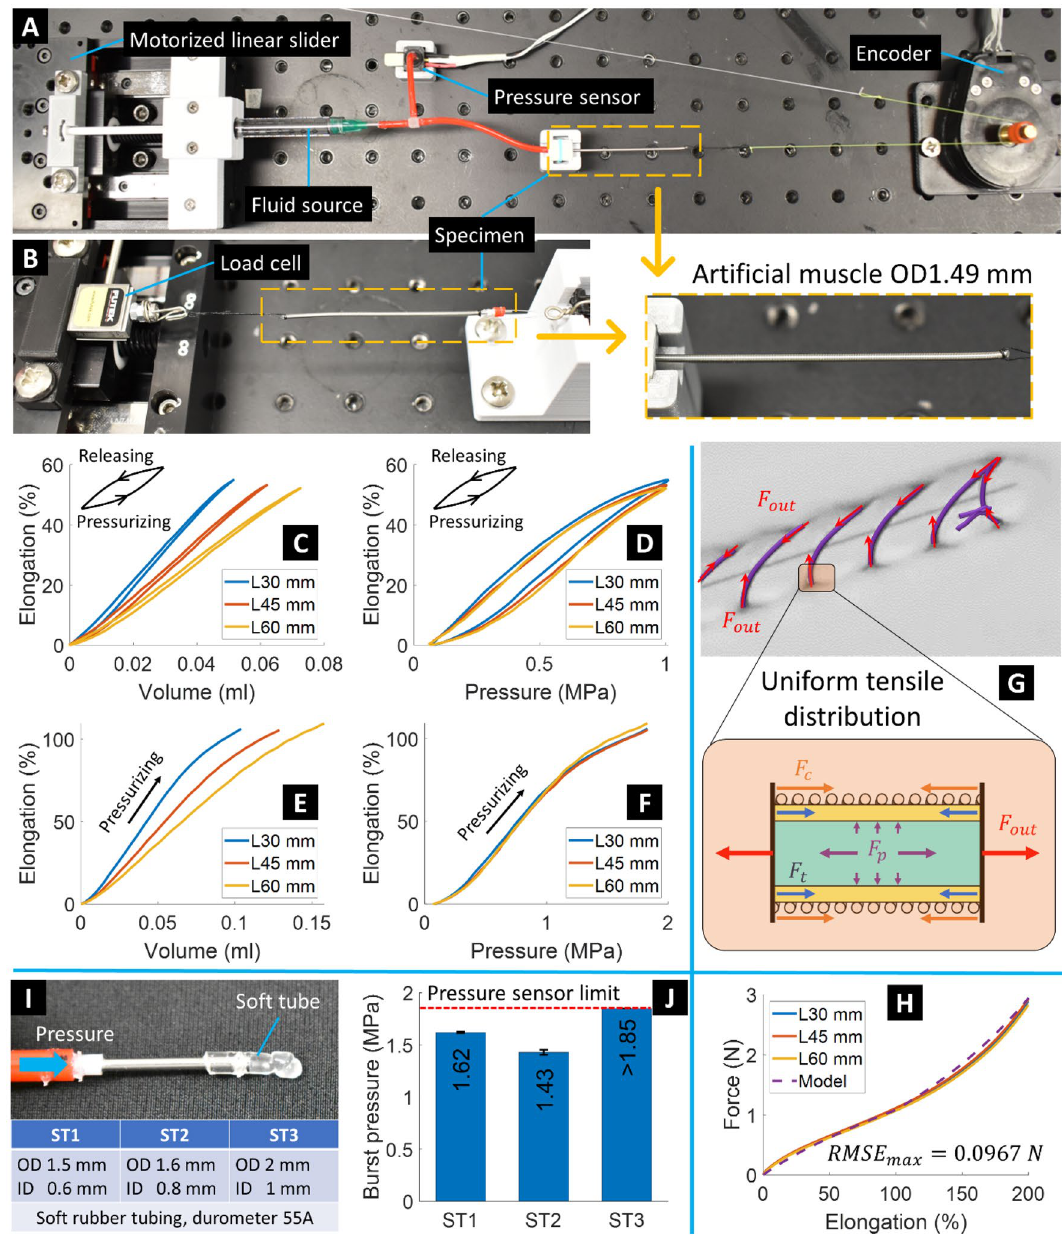
Figure 4. STAM and soft tube characteristics. ( A ) Experimental setup to measure STAM elongation. ( B ) Setup to establish the STAM elongation-force relationship. ( C , D ) Hysteresis profiles of input (volume and pressure) and output elongation of three different STAM lengths, when supplying pressure until 1 MPa. ( E , F ) Same as C and D but with input pressure reaching pressure sensor limit (1.85 MPa). ( G ) Uniform tension distribution of a small segment of the STAM. ( H ) Elongation-force relationship of three different STAM lengths accompanied by the analytical modeling result (RMSE: root mean square error). ( I ) Setup to measure burst pressure of soft tubes and a table shows specimens’ specifications. ( J ) Burst pressure of three soft tube